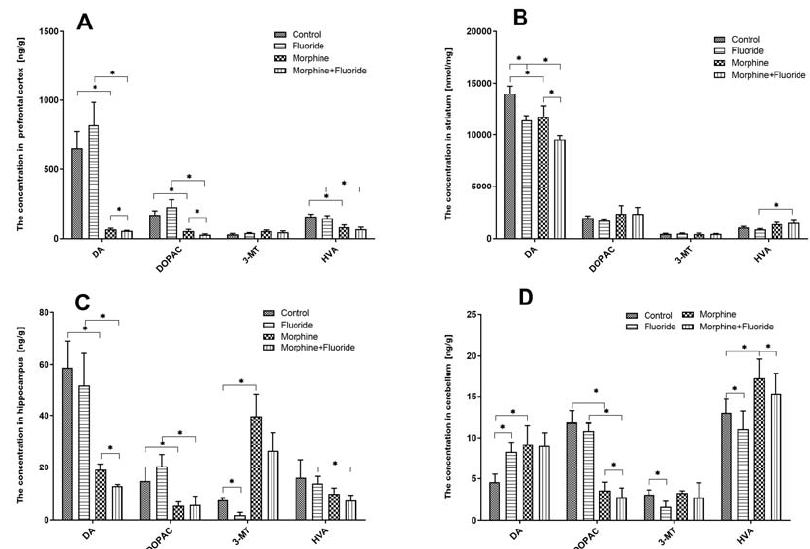
Figure 2. The concentrations of DA, DOPAC, HVA, and 3-MT (ng / g) in the prefrontal cortex ( A ), striatum ( B ), hippocampus ( C ), and cerebellum ( D ) of the rat brain in the control, fluoride, morphine, and morphine + fluoride groups. Rats were treated with 50 ppm of NaF and / or were administrated morphine in increasing doses (10–50 mg/kg). The results are presented as means ± SD. The statistical analysis was performed using the Mann ‐ Whitney U test, * p < 0.05.